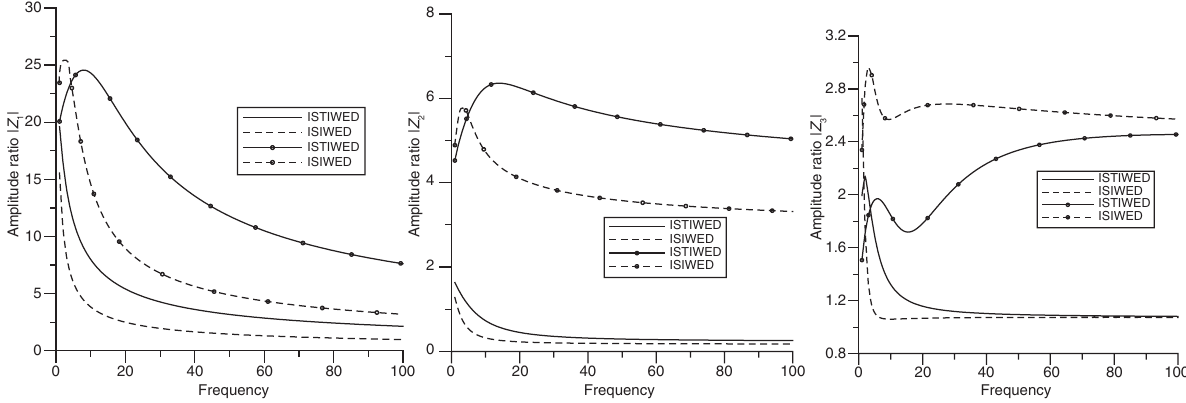
| ( i = 1, 2, 3) with frequency for incident i